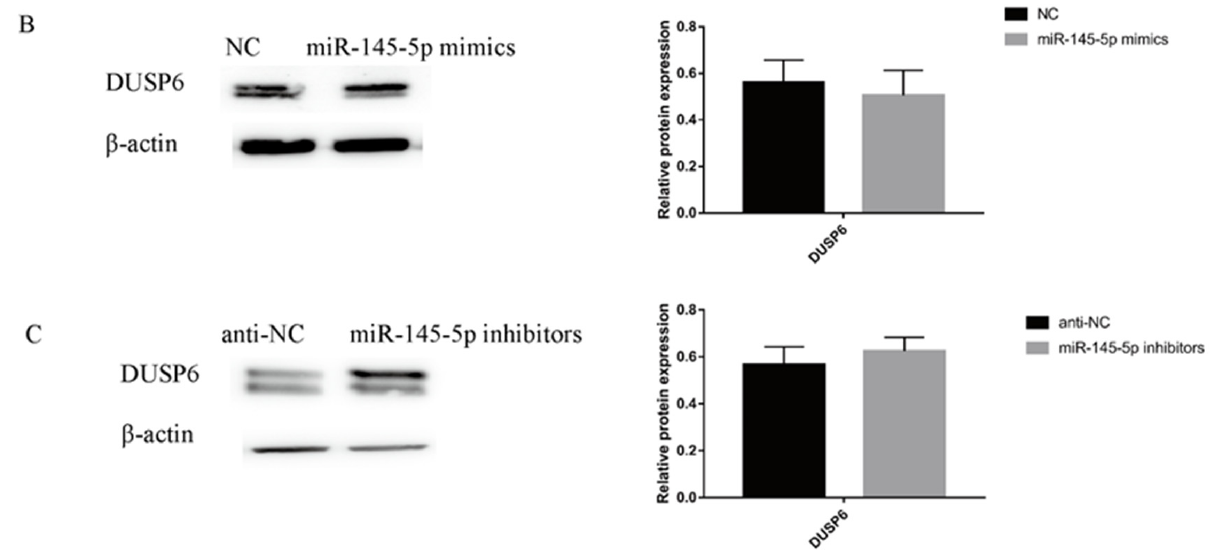
Figure 4. Relationship between DUSP6 and miR-145-5p. ( A ) Dual luciferase gene reporter assay of DUSP6 wild-type vector and DUSP6 mutant-type vector transfected with miR-145-5p mimics. ( B , C ) Protein expression of DUSP6 in the upgrade and knockdown groups. No asterisk, p > 0.05; *, p < 0.05.